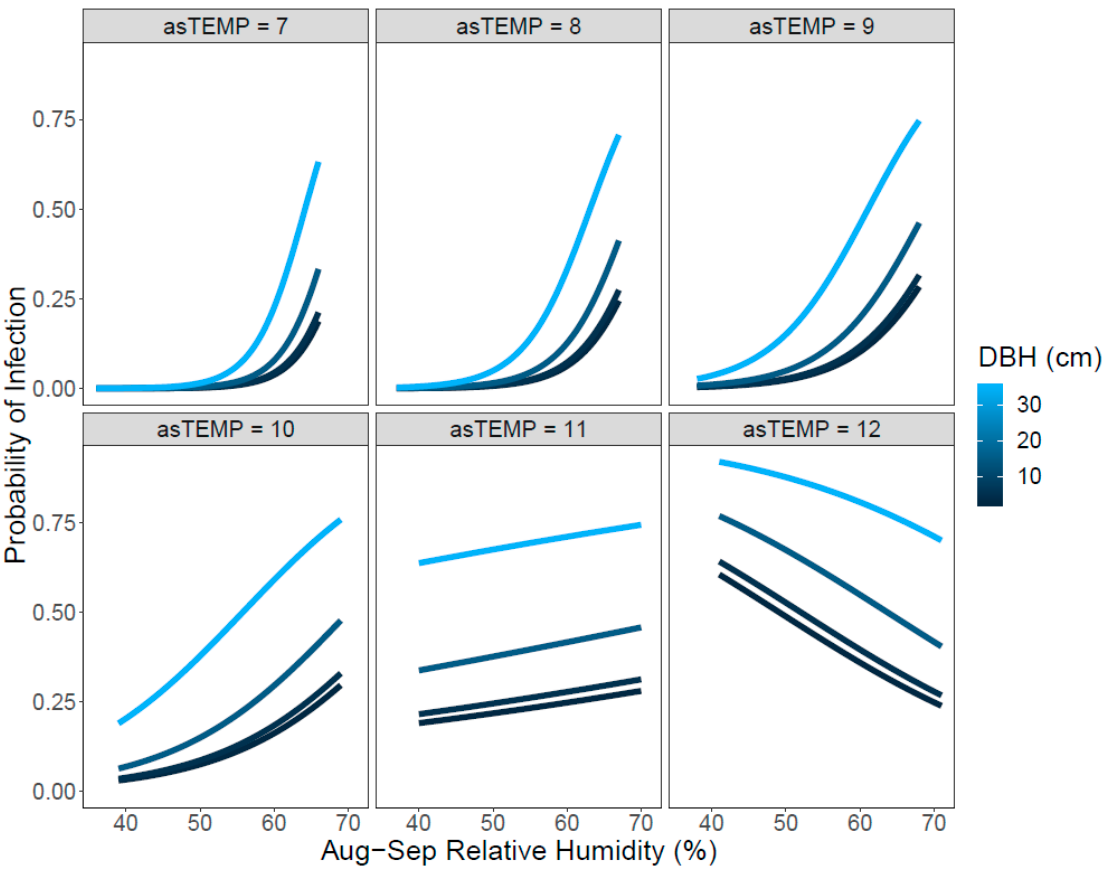
Figure 5. Probability of white pine blister rust infection by diameter at breast height (DBH) of whitebark pine trees as a function of average August–September relative humidity (asRH) for six levels of average August–September temperature (asTEMP). The panel labels indicate scenarios of average temperature (°C) that span the range of the average August–September temperature at monitored stands.